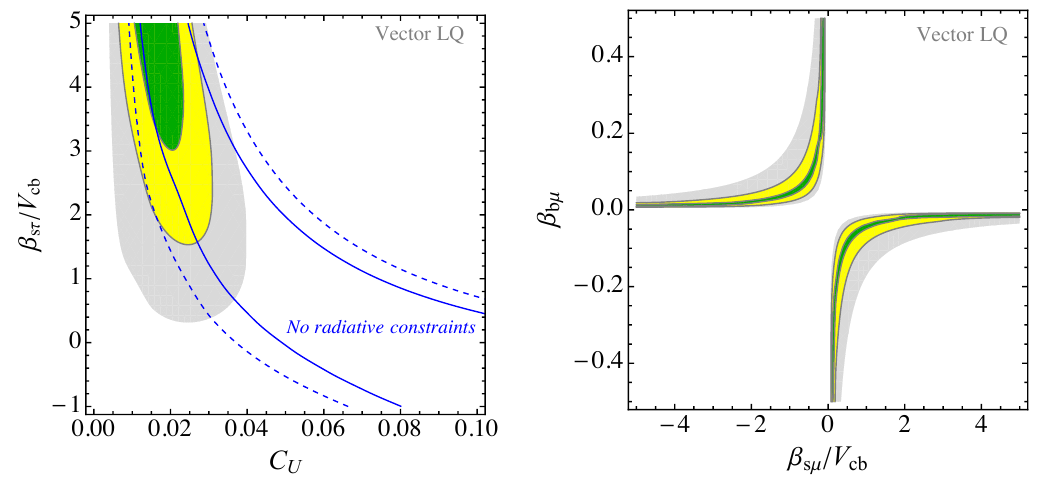
Figure 4 . Fit to semi-leptonic and radiatively-generated purely leptonic observables in table 1, for the vector leptoquark U (cid:22) , imposing j (cid:12) s(cid:22);s(cid:28) j < 5 j V cb j and C U > 0. In green, yellow, and gray, we show the (cid:1) (cid:31) 2 (cid:20) 2.3 (1 (cid:27) ), 6.0 (2 (cid:27) ), and 11.6 (3 (cid:27) ) regions, respectively. The dashed and solid